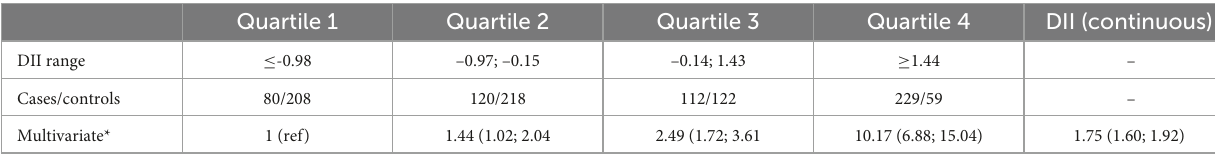
TABLE 3 Odds ratios (OR) and confidence intervals for quartiles of dietary inflammatory index (DII) (and DII as continuous) associated with the diet of patients with multiple